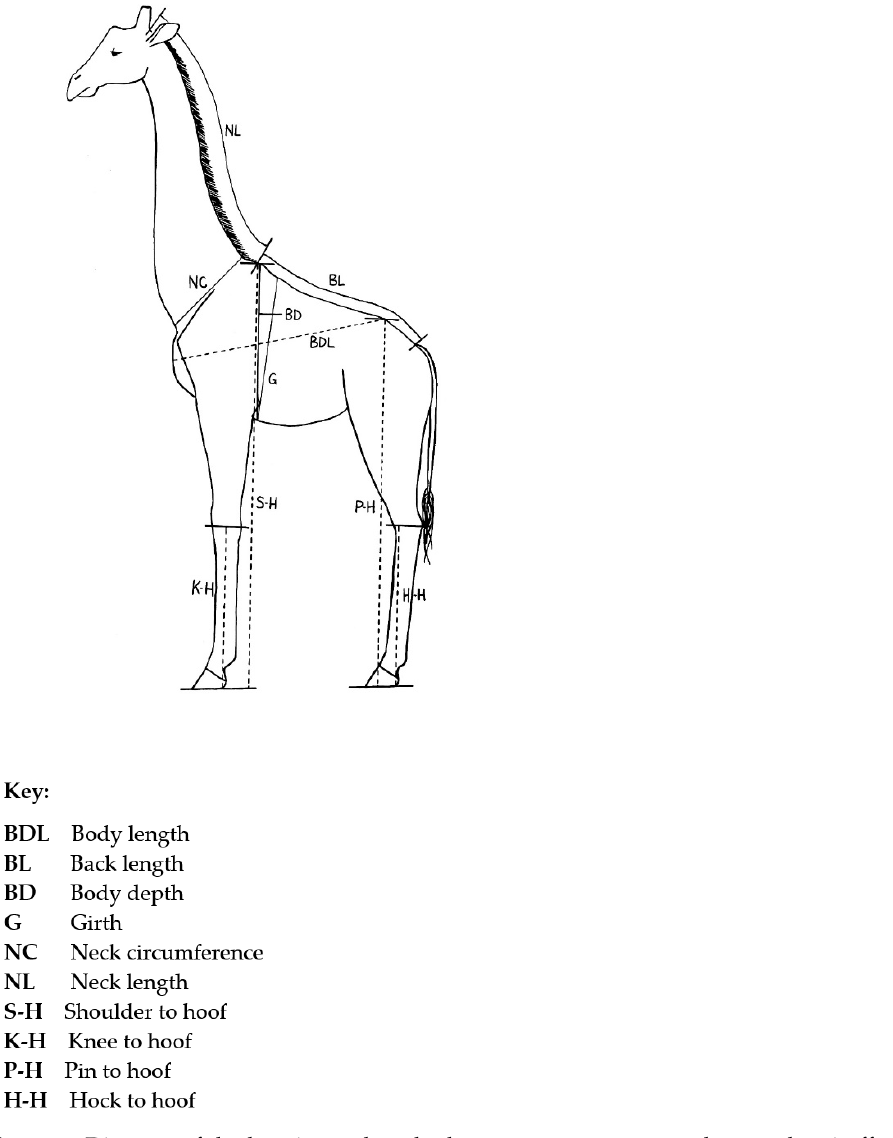
Figure 1. Diagram of the locations where body measurements were taken on the giraffe ( Giraffa camelopardalis angolensis ).